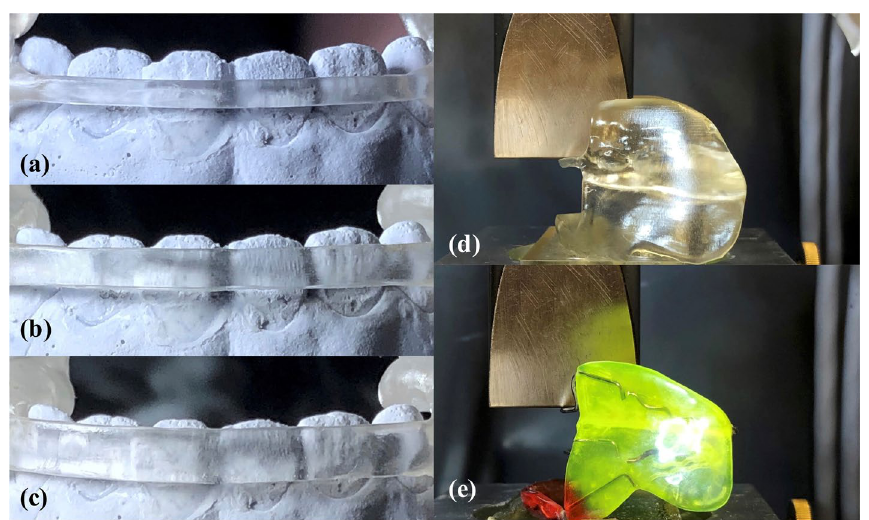
Figure 4. Testing of different labial CAD/CAM archwires. Before transversal load testing, three different labial CAD/CAM archwires (CAD-L) dimensions ( a – d ) were tested and compared to the conventional labial archwire (Con-L; e ) in order to find a suitable CAD-L design that could be integrated in the final CAD/CAM functional regulator 3 designs for further transversal testing. The optimum CAD-L should be as slim as possible but have sufficient load capacity (Fmax(L)) and stiffness values comparable to those of the Con-L. All labial archwires were loaded caudally, to simulate resistance during insertion. Load was applied until mechanical failure was detected or until the deflection of the labial arch reached a predefined maximum value of 15